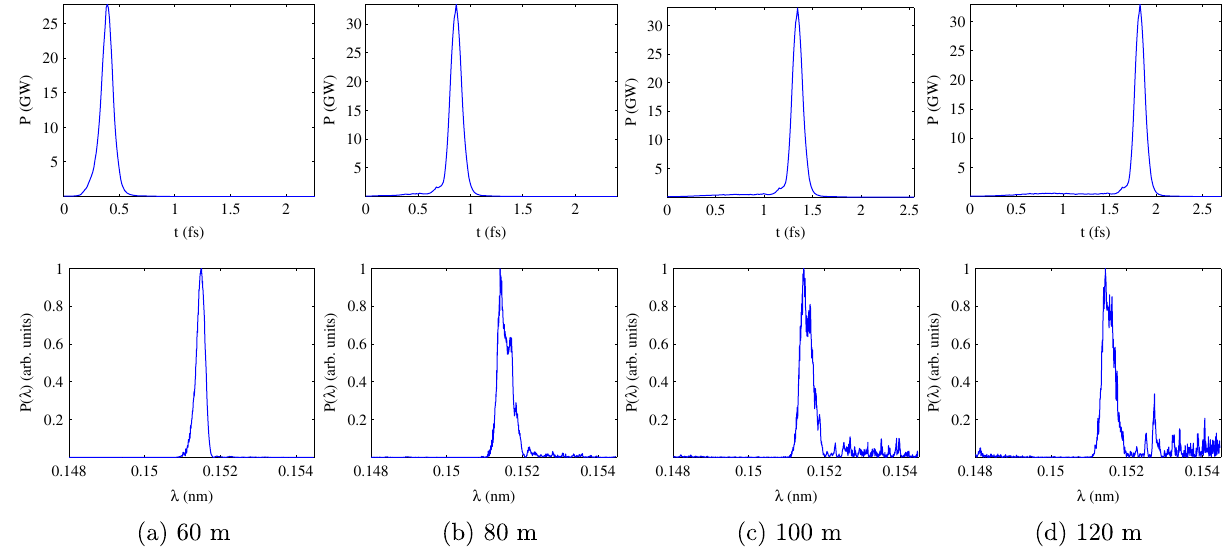
FIG. 9. Simulation results on the FEL power profile (upper) and spectrum (lower) at different locations in the undulator using the electron beam in Fig. 4(b), where the L2 rf phase is − 35 . 3 ° and the undulator is tapered at Δ K=K ¼ − 1% from 20 to 132 m. L2 rf phase is at − 35 . 3 °, which is averaged over the 20 shots. We can see from the figure that the FEL saturates around the distance of 60 m in the undulator with the power of about 35 GW, and the pulse duration is below 140 as.